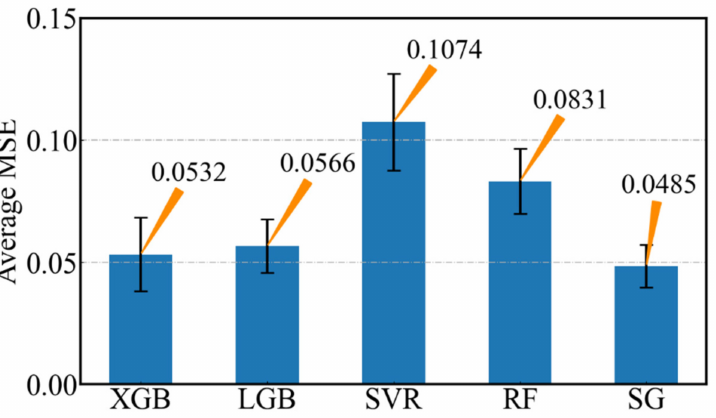
Figure 14. MSE results of the